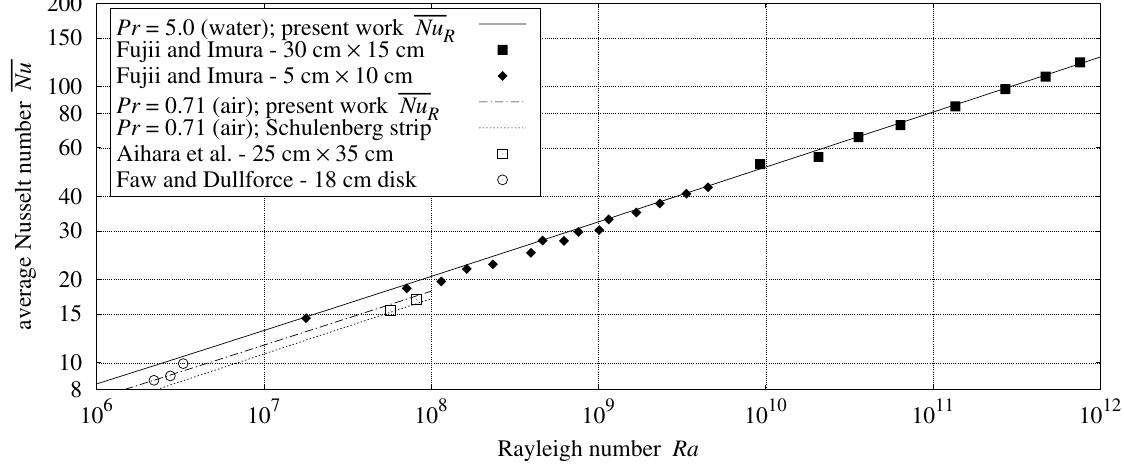
Figure 6. Downward convection heat transfer from horizontal plate. Table 7. Downward convection heat transfer from horizontal